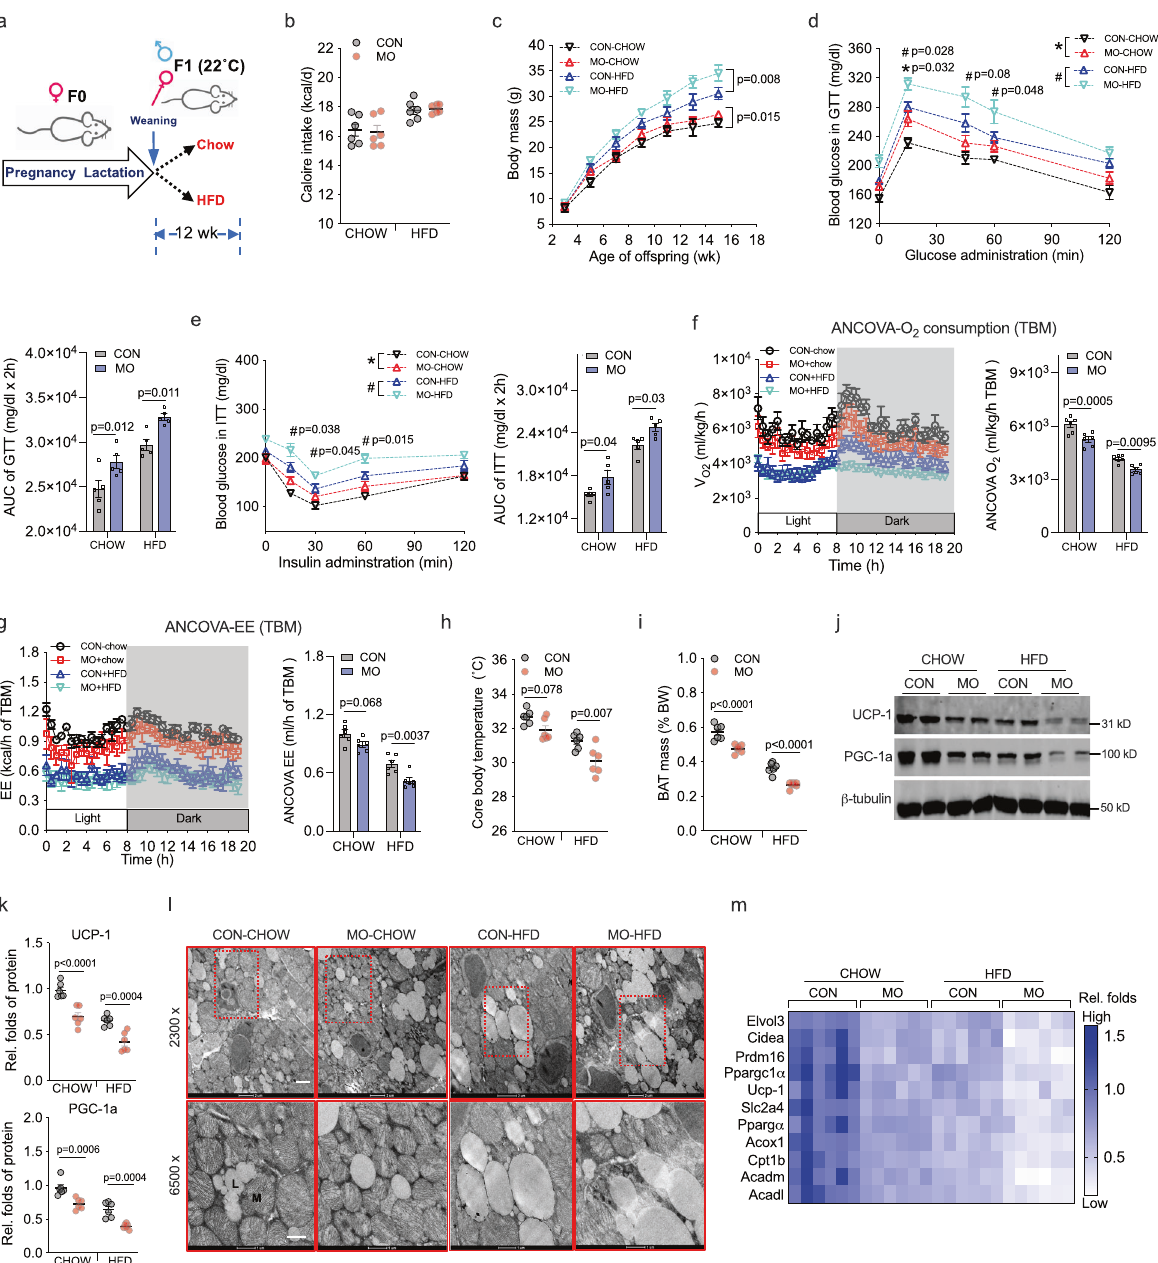
Fig. 1 Maternal obesity (MO) reduces thermogenesis and energy expenditure of brown fat (BAT) and increases risks of metabolic dysfunctions in female offspring at 22 °C. a At weaning, male and female offspring born to control and MO dam (C57BL/6J) were fed a regular diet (chow, 10% calorie from fat) or high-fat diet (HFD, 60% calorie from fat) for 12 weeks ( n = 6) at 22 °C. b , c Calorie intake ( b ) and body mass ( c ) of female offspring fed chow or HFD ( n = 6). d , e After 6 h of fasting, female offspring were administrated with glucose or insulin for measuring glucose tolerance (GTT) ( d ) and insulin sensitivity (ITT) ( e ) ( n = 5). * represents the difference between control and MO offspring fed chow diet, # represents the difference between control and MO offspring fed HFD, analysis was performed by Two-way ANOVA with adjustment-comparison test. f , g O 2 consumption ( f ) and energy expenditure ( g ) of female offspring ( n = 6). Metabolic data were regressed to total body mass according to NIDDK MMPC ANCOVA analyses. h Measurement of core body temperature in female offspring rectum ( n = 6). i Interscapular brown fat (BAT) mass (% body weight) in female offspring. j , k Abundance of UCP-1 and PGC-1a proteins in BAT measured by immunoblotting. β -tubulin was used as a loading control ( n = 6). l Mitochondria and lipids in BAT were imaged by transmission electron microscopy (TEM) at ×2300 (scale bar: 2 µ m) and ×6500 (scale bar: 1 µ m) magni fi cation ( n = 4). m Heatmap shows mRNA expression of BAT thermogenic genes and genes in glucose and fatty acids uptakes. The mRNA expression was normalized to 18 S rRNA ( n = 6). For data analyses, each pregnancy (dam) was considered as a replicate unit. Data are presented as mean ± s.e.m. Signi fi cance was determined by two-way ANOVA with Bonferroni post hoc analysis, and body mass curve was measured by two-way ANOVA with repeated measurements.